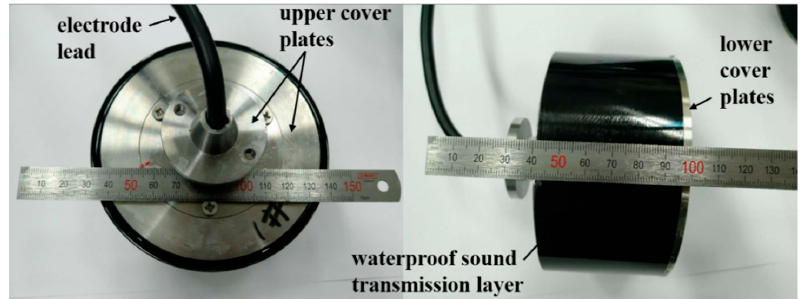
Figure 12. The high-frequency broadband circular transducer.